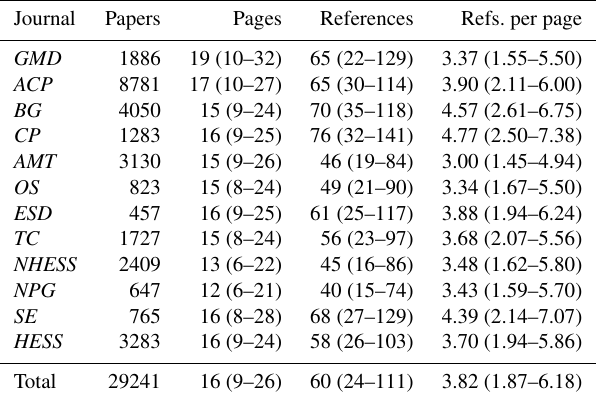
Table 3. Average numbers of pages, references and references per page (Refs. per page) for different EGU journals for all analysed papers. The range at 90% confidence level is listed in